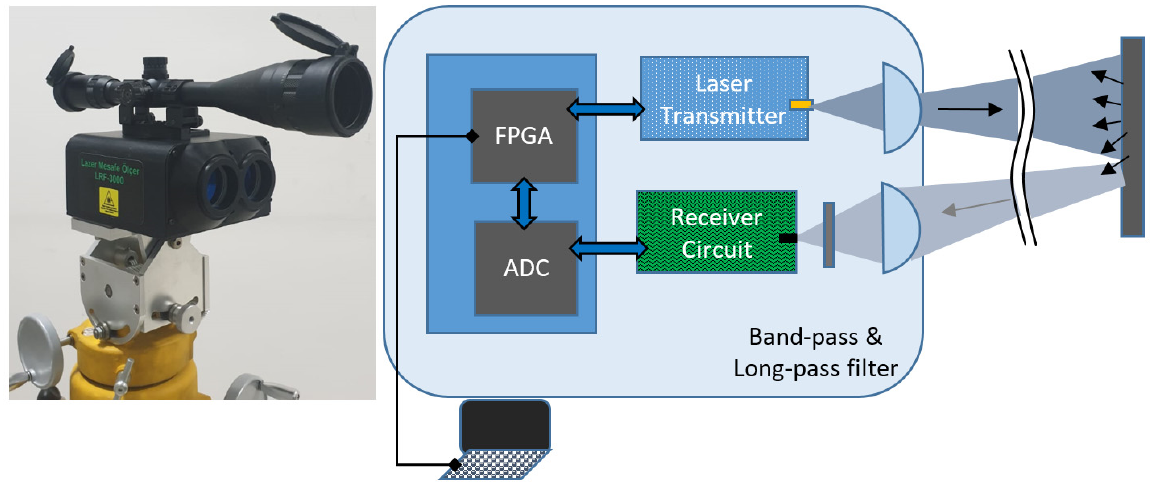
Figure 2. Experimental setup on the left is shown on tripod. On the right , the basic layout of the LRF is depicted.